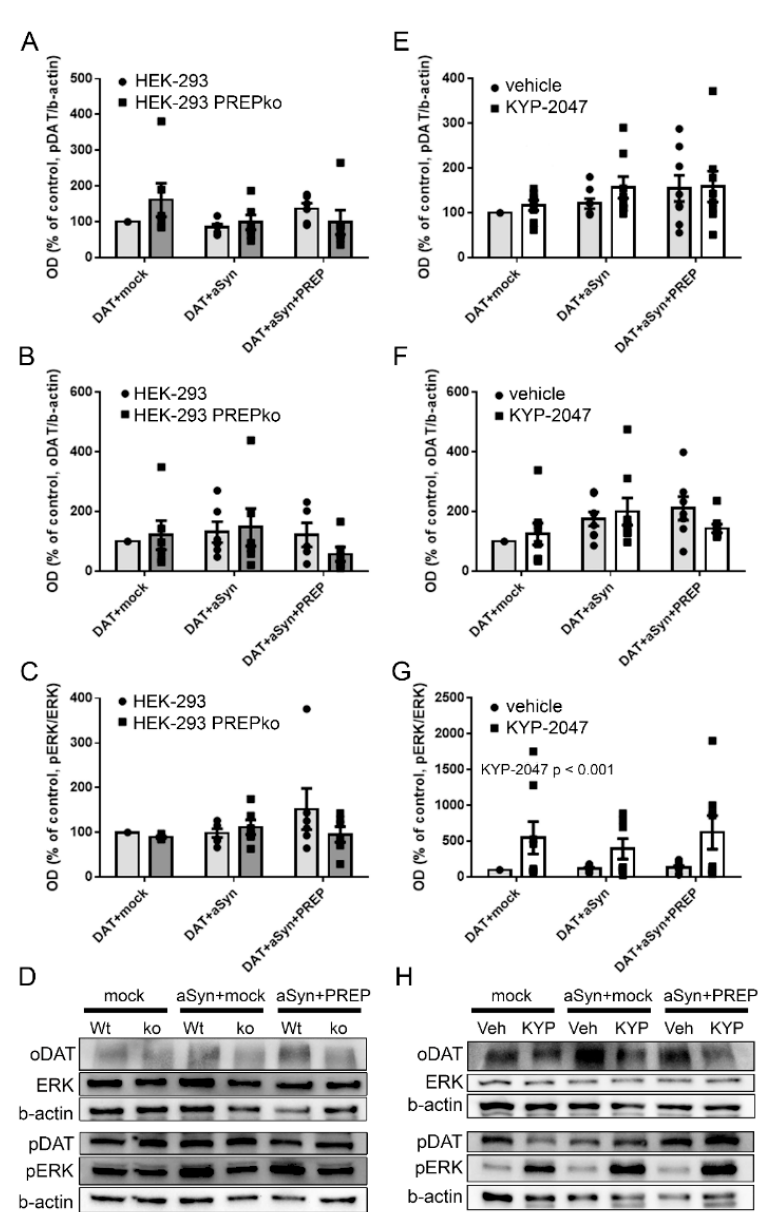
Figure 2. PREP inhibition elevates phosphorylation of ERK but does not have an effect on phos- phorylation of DAT. Wt HEK-293 cells and PREPko HEK-293 cells were transfected with DAT and mock, DAT and aSyn or DAT, aSyn, and PREP ( A – D ). Wt HEK-293 cells with similar transfections were treated with vehicle or 1 µ M KYP for 30 min prior to cell lysis 48 h after transfection ( E – H ). The oDAT, pDAT, ERK, and pERK were measured by WB. Optical-density values were normalized to the loading control ( β -actin) optical density. Overexpression of aSyn or a combination of aSyn and PREP did not have a statistically significant effect on phosphorylation ( A ) or oligomerization of DAT ( B ), and deletion or inhibition of PREP did not change the effect. However, PREP inhibition increased phosphorylation of ERK ( G ), but PREP deletion did not ( C ). Representative WB for figures ( A – C , G ), and for ( E – G , H ). Data were collected from 6–8 independent WBs that were done with samples from 6–8 independent cell culture preparations. Bars represent mean ± SEM. p -value is from two-way